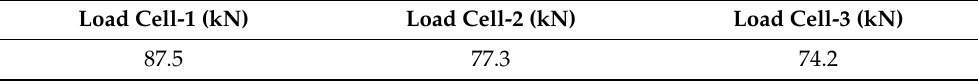
Table 8. Maximum load cell values subjected to fiber-reinforced polymer (FRP) prestressing.